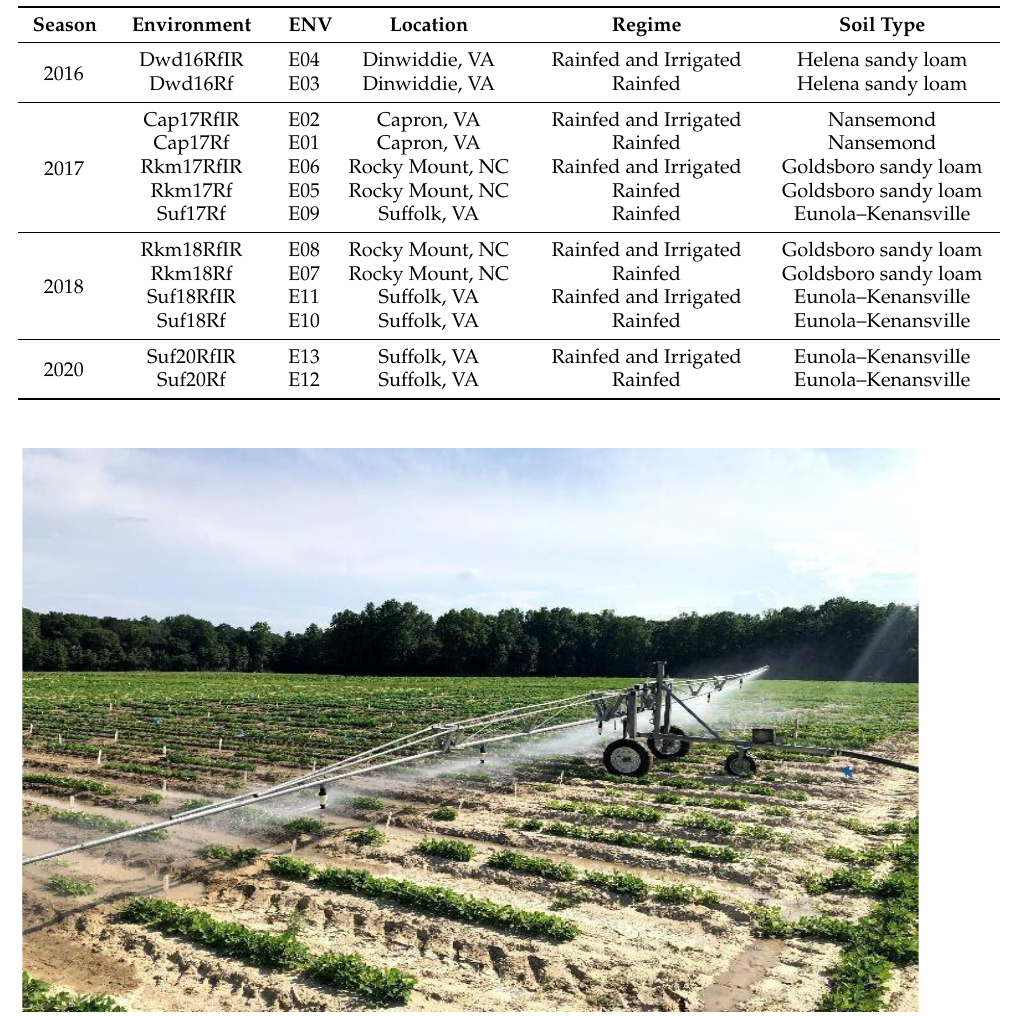
Figure 1. Lateral-pull boom cart sprinkler irrigation system used to irrigate the